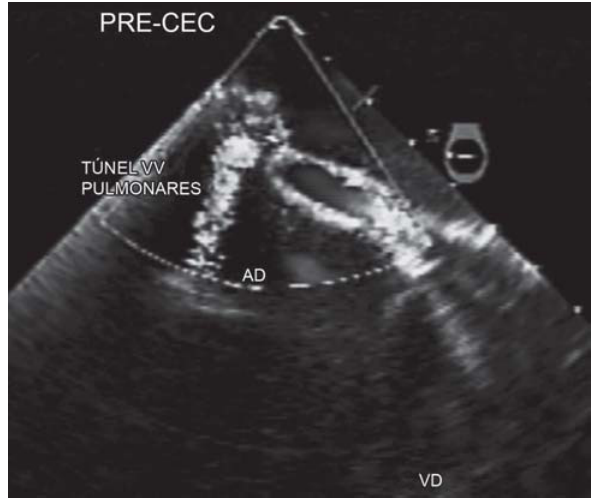
Fig. 1 - Ecocardiograma transesofágico com Doppler, em corte no nível do átrio direito e o túnel das veias pulmonares, evidenciando estenose do túnel das veias pulmonares. AD: átrio direito, VD: ventrículo direito, PRE-CEC: prévio à circulação extracorpórea. Túnel VV Pulmonares: túnel veias